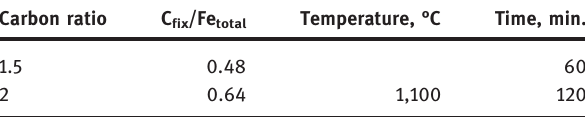
Table 5: The reduction conditions for pellet material. Carbon